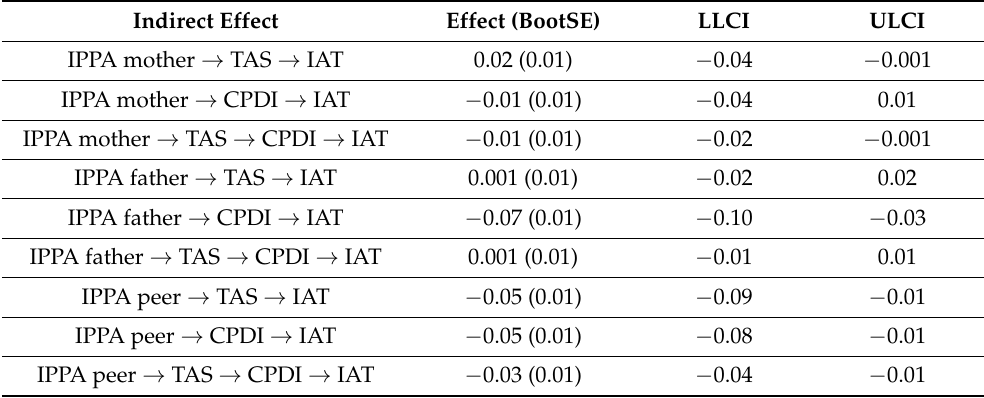
Table 5. Indirect effects of young adult university students’ attachment to mothers, fathers, and peers on Internet Addiction through alexithymia and peritraumatic distress due to COVID-19. Indirect Effect Effect